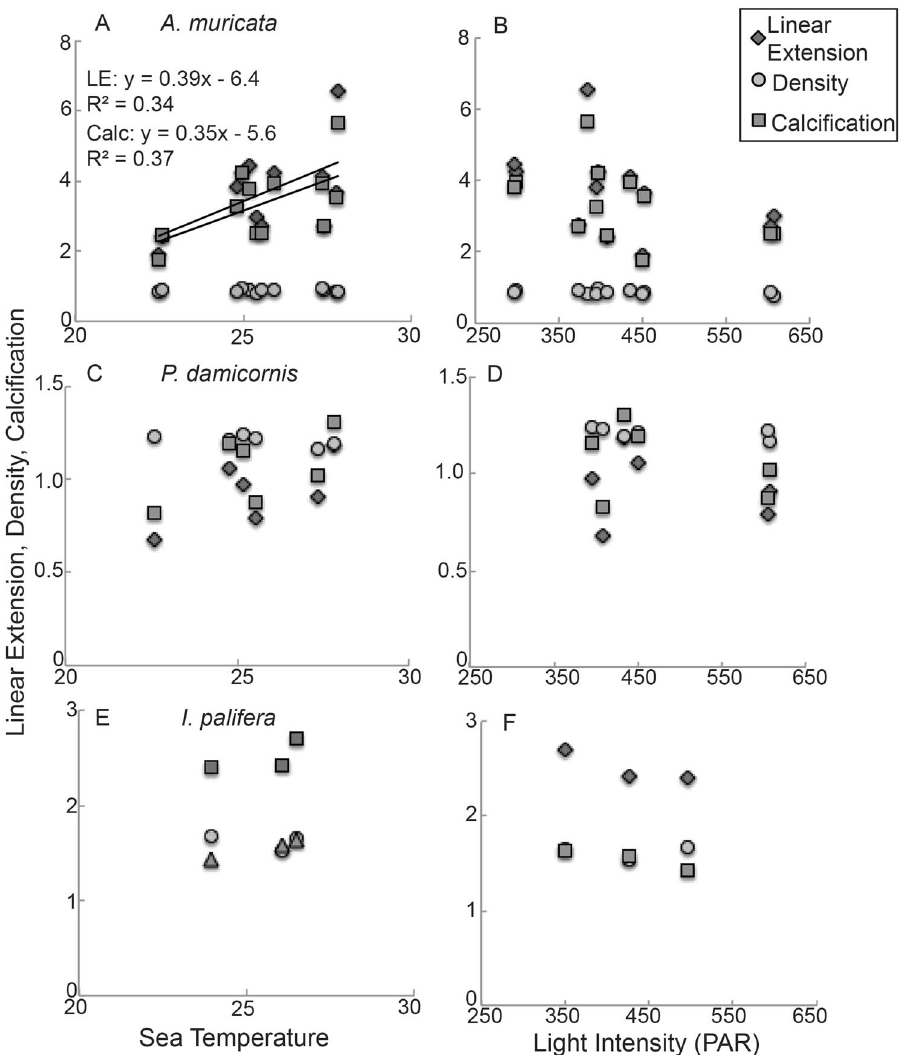
Figure 5. The relationship of summer and winter linear extension (cm 6-month − 1 ), density (g cm − 3 ) and calcification (g cm − 2 6-month − 1 ) of Acropora muricata ( A , B ) Pocillopora damicornis ( C , D ), Isopora palifera ( E , F ) from 2012–2014 against average seasonal (6-month) sea surface temperature (°C) and light intensity (PAR) for all reef locations (Lizard, Davies, Heron) and sampling periods for each species. Line of best fit delineates a significant